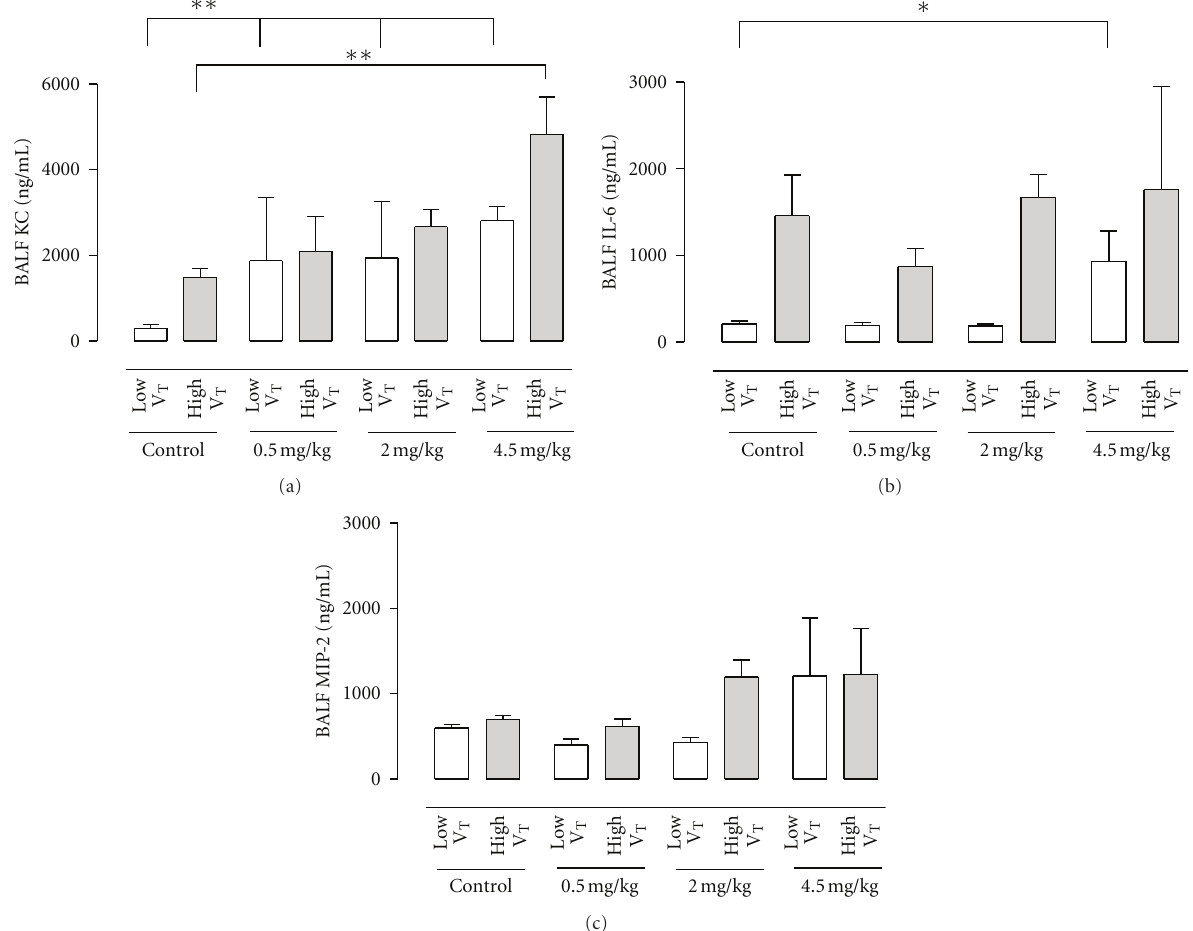
Figure 3: (a) Keratinocyte-derived chemokine (KC) ( n = 12 per group), (b) interleukin (IL)-6 ( n = 6 per group) and (c) MIP-2 concentrations ( n = 6 per group) in the bronchoalveolar lavage fluid (BALF). Ventilated animals receiving 0.5 mg/kg, 2.0 mg/kg, or 4.5mg/kg MHC-I antibody. Animals were low V T (tidal of 7.5 mL/kg) and high V T (tidal of 15 mL/kg). Controls received vehicle. ∗ P < 0 . 05, ∗∗ P < 0 . 01.